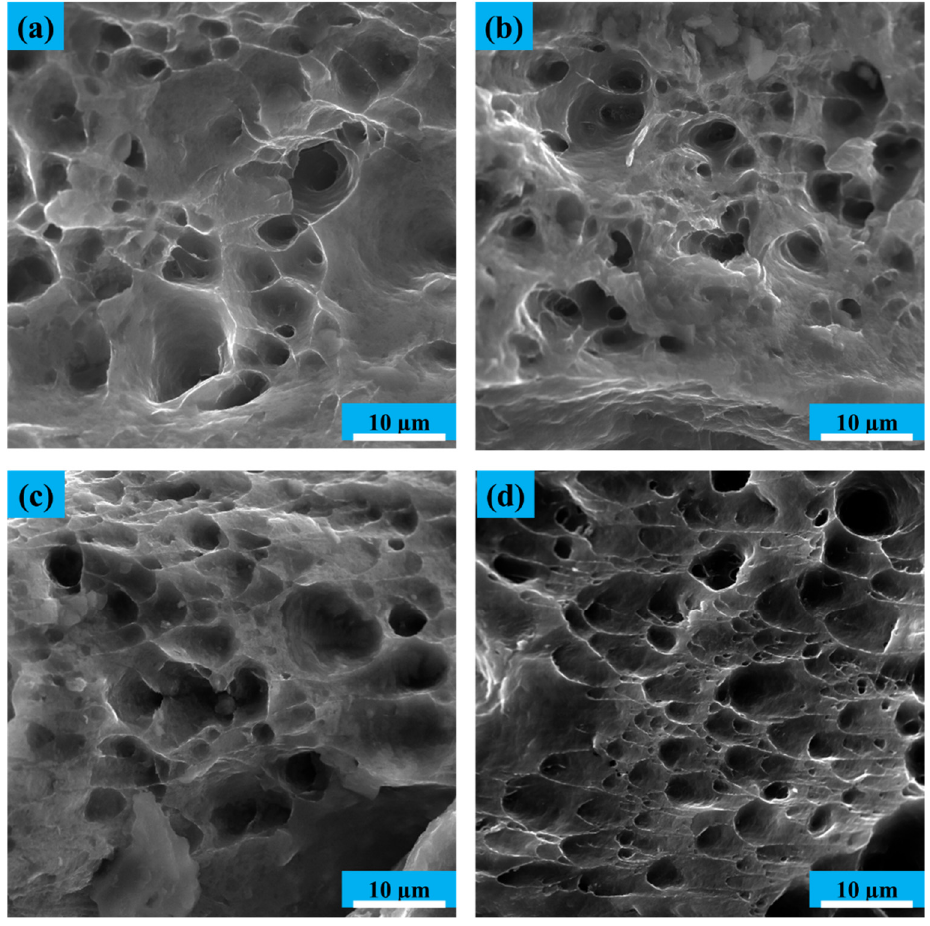
Figure 7. Fracture surfaces of the tensile annealed sample and ARBed samples: ( a ) Annealed sample; ( b ) first ARB pass; ( c ) third ARB pass; ( d ) fifth ARB pass.